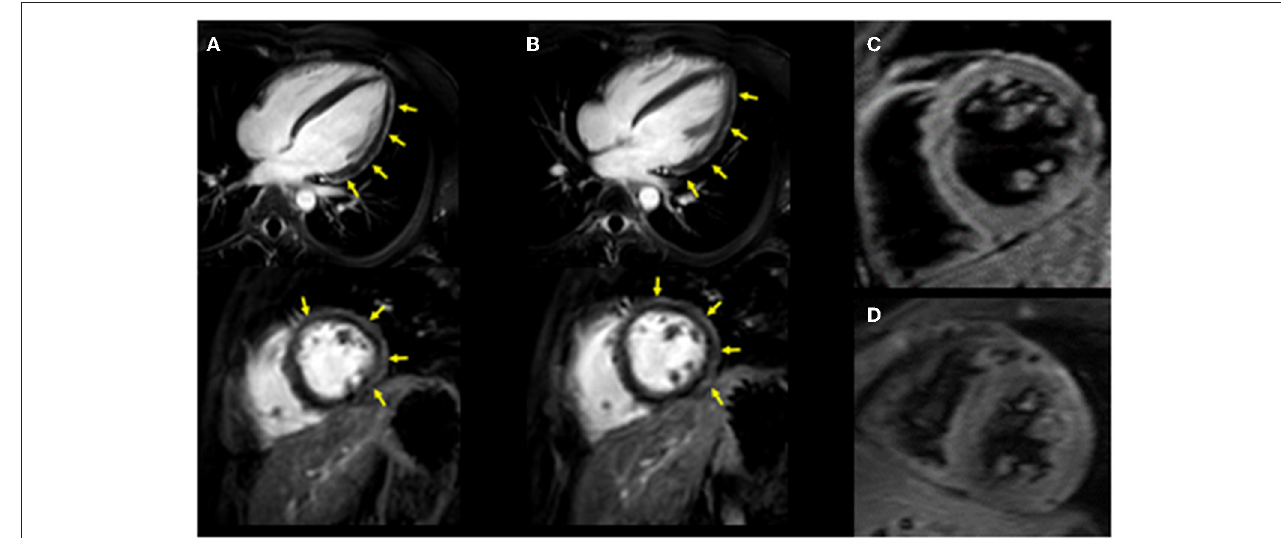
FIGURE 1 | Cardiac MRI imaging. Diffuse late gadolinium enhancement at the epicardium was observed in both images. (A) Images obtained 3 years ago when he suffered from his previous myocarditis (top: long-axis view, bottom: short-axis view). (B) Images obtained during the current myocarditis episode associated with coronavirus disease-2019 (COVID-19) messenger RNA (mRNA) vaccination (top: long-axis view, bottom: short-axis view). T2-weighted MR images. (C) Image obtained 3 years ago when he suffered from his previous myocarditis episode. (D) Image obtained during the current myocarditis episode associated with COVID-19 mRNA